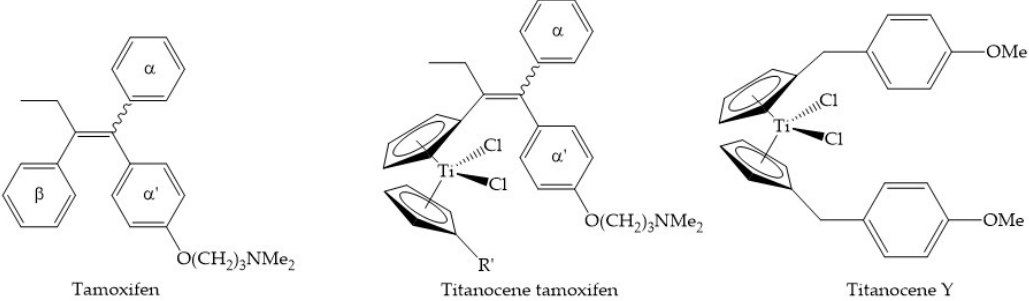
Figure 6. The chemical structures for tamoxifen, titanocene tamoxifen, and Titanocene Y.